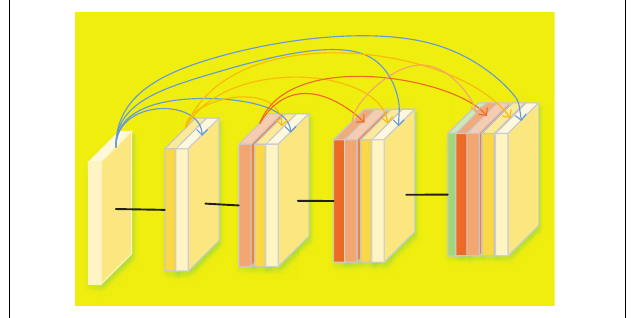
FIGURE 2 | Structure of the DenseBlock (5 layers and each layer takes feature maps from all previous